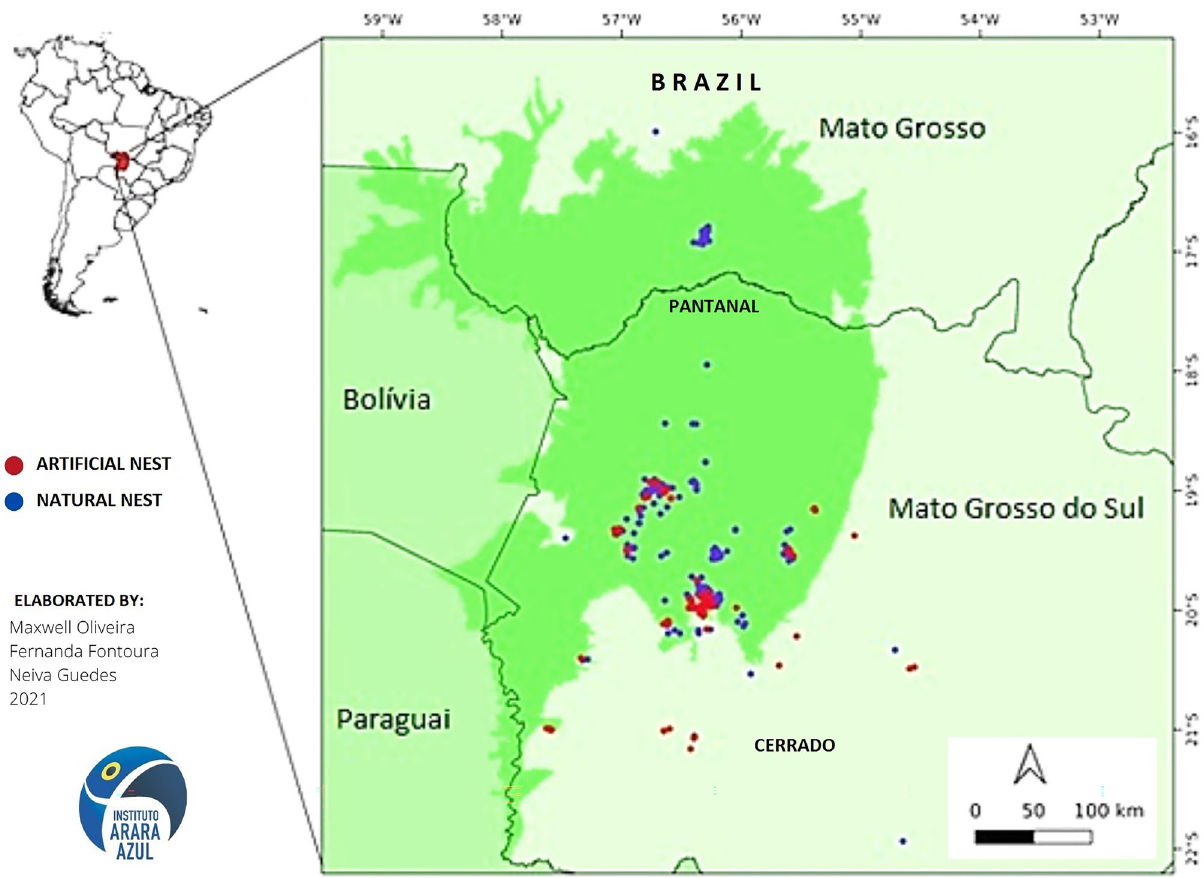
Figure 1. From 1991 to 2021, natural nests (n = 473, in blue) and installed artificial nests (n = 415, in red) were monitored in the Pantanal in the states of Mato Grosso do Sul and Mato Grosso, and more recently